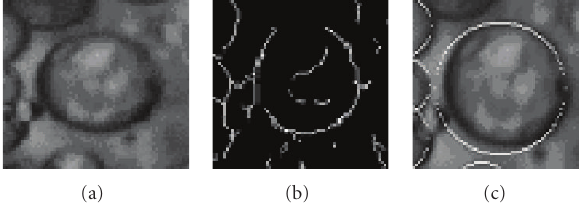
Figure 3: Original image, the edge detection and the detection of the drop using the Hough